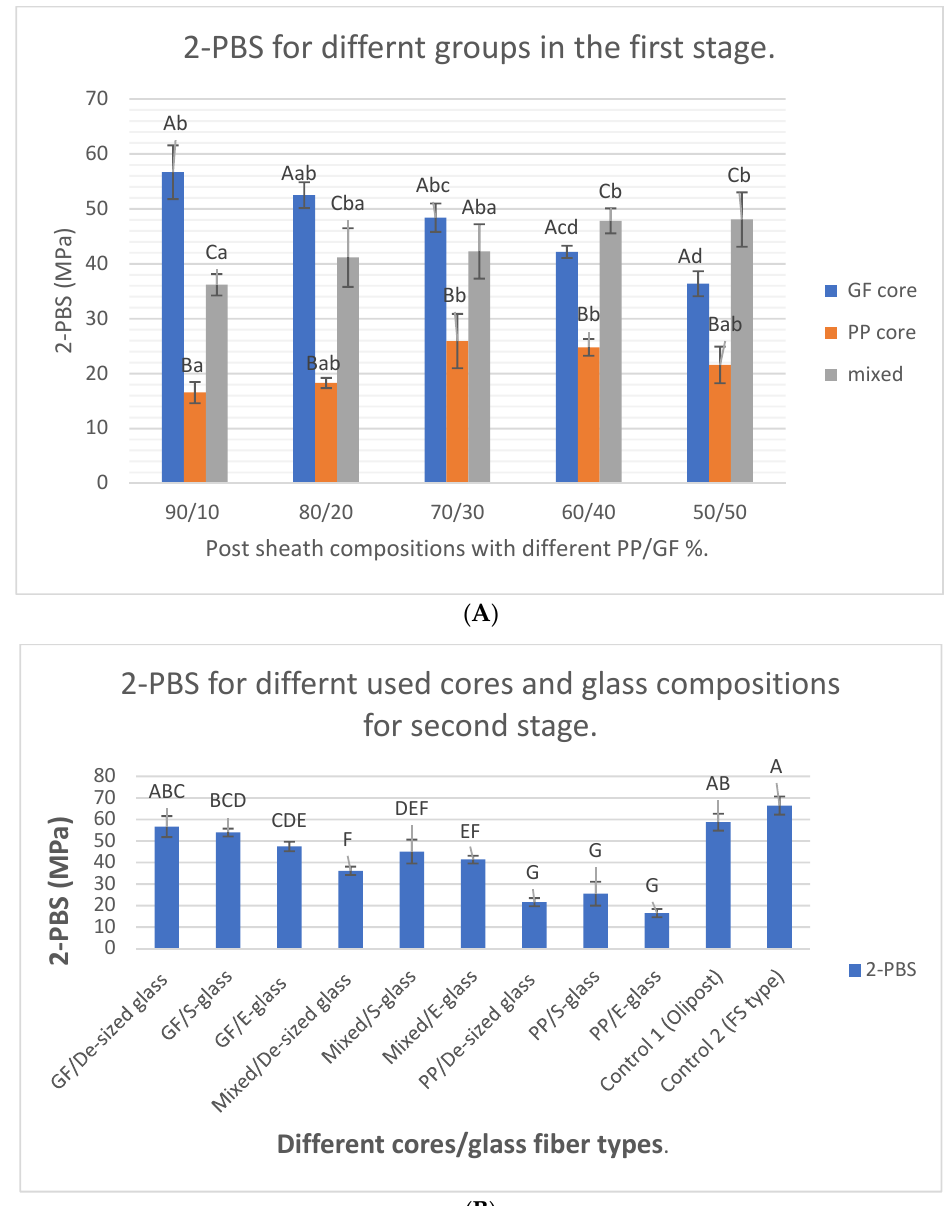
Figure 3. Bar charts showing the 45° angle compression testing (two-point bending strength) for first stage ( A ) with highest values were for GF cores in higher PP/GF % core composition and ( B ) for the second stage where de-sized Gf and S- glass fiber cores showed the closest two-point bending strength values to control 1 and 2 commercial post types. Upper and/or lowercase letters are for Tukey’s post-hoc test.